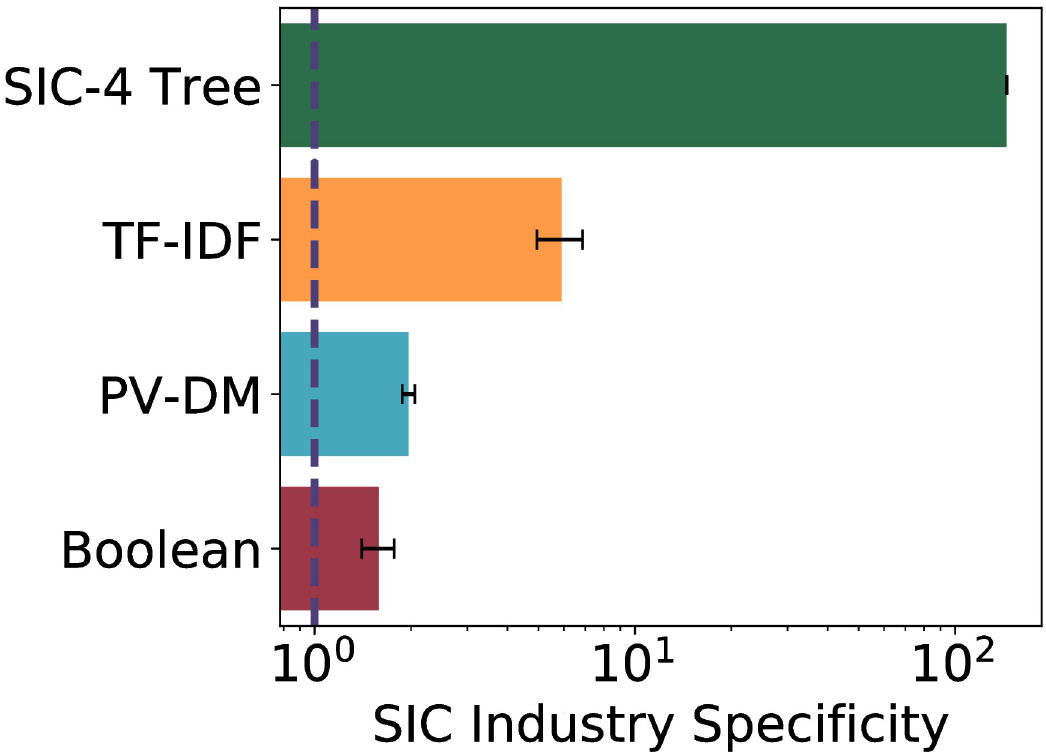
Fig 10. Industry Specificity with respect to SIC of text-based models (Boolean, TFIDF, and PVDM) and the text-free SIC control. The dotted line shows the null hypothesis of a perfectly flat similarity matrix.